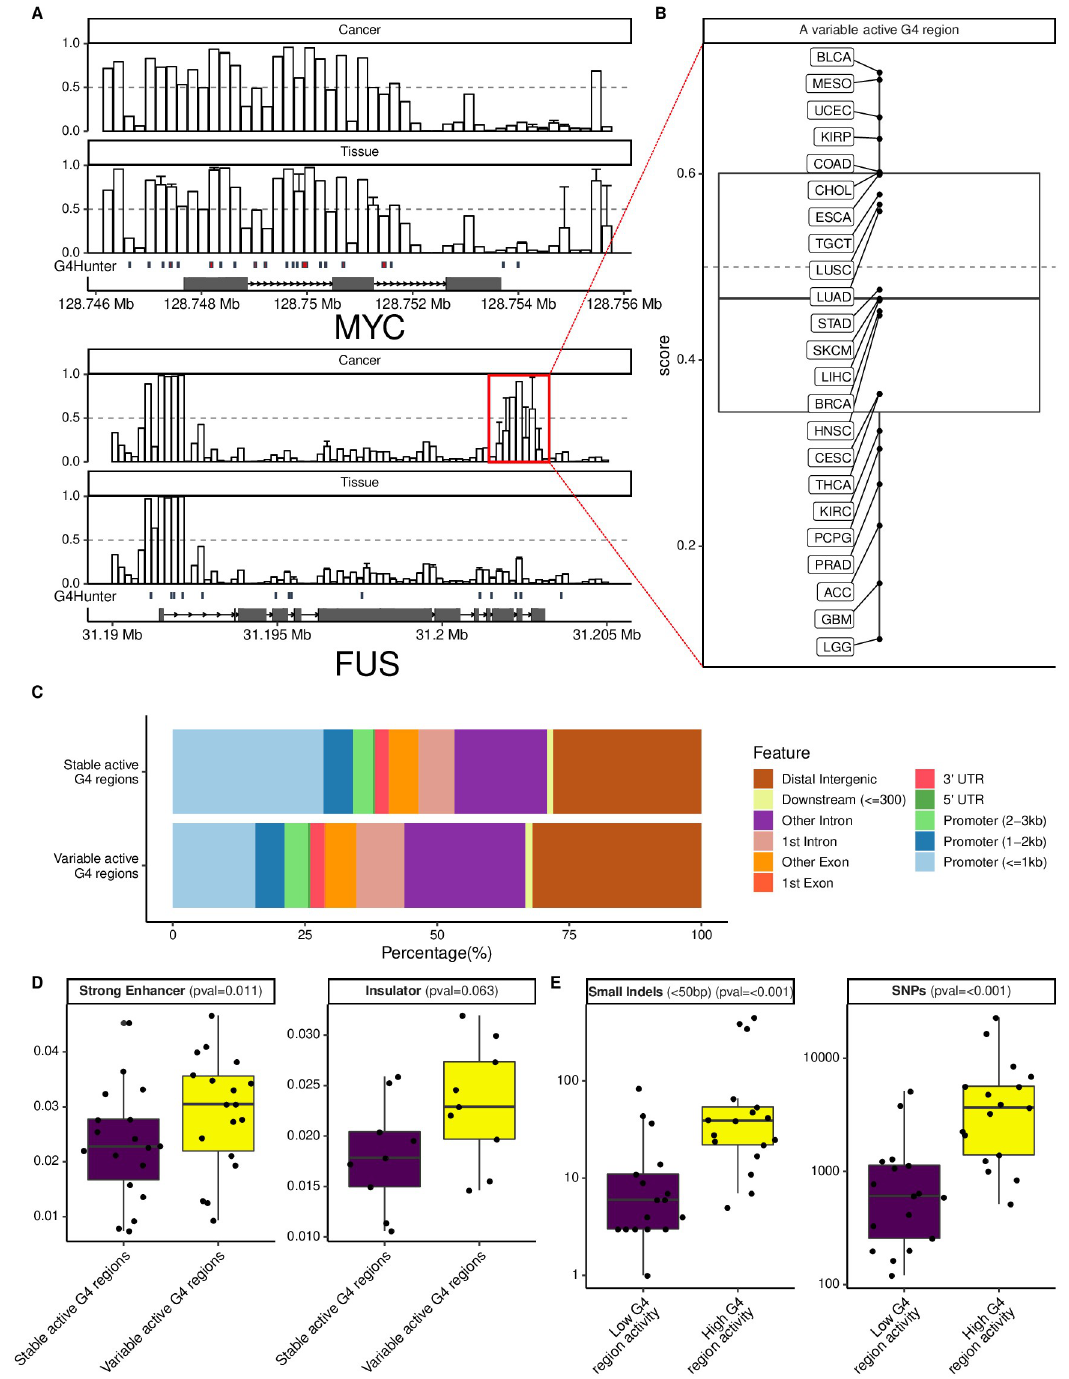
Fig 5. Genome-wide prediction of active G4 regions in tissues and cancers. A) Genome browser of DeepG4 predictions at MYC and FUS genes in tissues and cancers. B) Relationship between DeepG4 predicted G4 activity and the amount of mutations, depending on the mutation class. Cancer cohort abbreviations ( e.g . MESO) are detailed in S1 Table. C) Annotations of predicted stable and variable active G4 regions. D) Mutation rates in BRCA breast cancer depending on predicted G4 region activity.